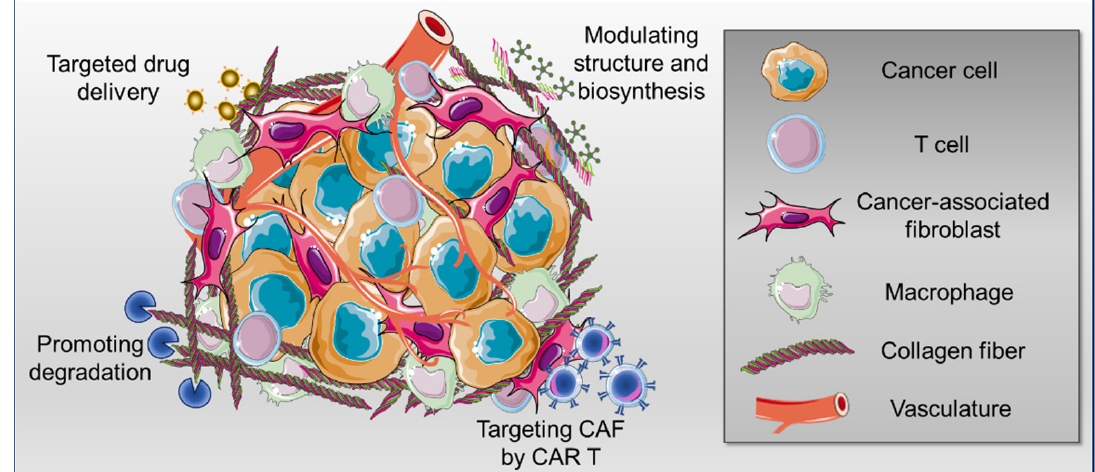
Figure 1. Schematic representation of different strategies of therapeutic targeting of tumor collagen.